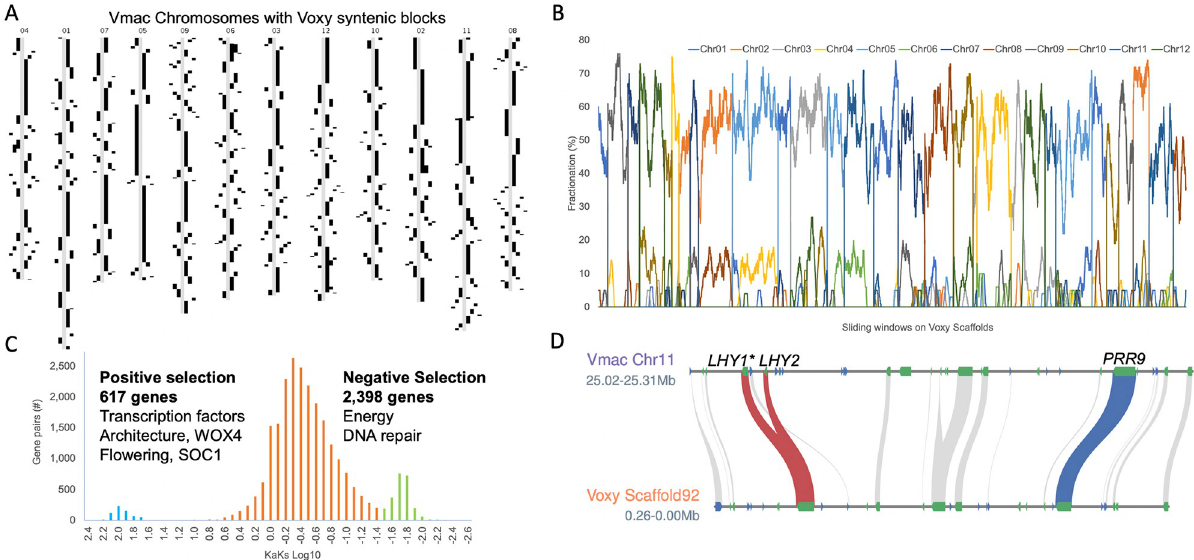
Fig 3. V . macrocarpon is highly syntenic to its wild relative V . oxycoccos . A) Voxy syntenic blocks (black) visualized on Vmac (grey) chromosomes. B) Fractionation of Vmac genes (chromosomes labeled in color) across Voxy scaffolds shows 2:2 syntenic depth with 60% genes present in the most recent whole genome duplication (WGD). C) Non-synonymous (Ka) by synonymous (Ks) base changes between Vmac and Voxy syntenic pairs reveals genes under positive (blue; far left) and negative (green; far right) selection. D) Conserved linkage between core circadian clock genes LATE ELONGATED HYPOCOTYL ( LHY ; red lines) and PSEUDO RESPONSE REGULATOR 9 ( PRR9 ; blue line) maintained on Vmac Chr11 and Voxy Scaffold92; other syntenic genes in the region (grey). Vmac has a tandem duplication of LHY ( LHY1 and LHY2 ) not found in Voxy, and under positive selection ( � ) in the cranberry cultivar Mullica Queen